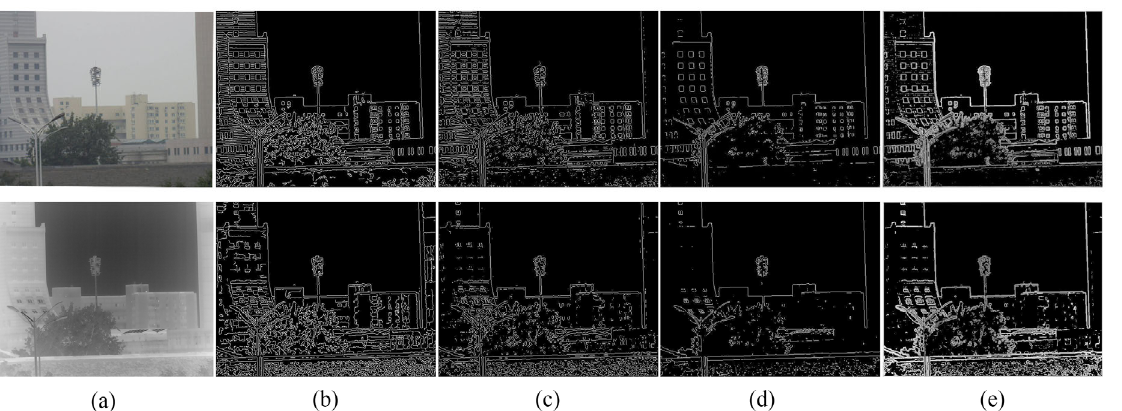
Figure 7. Evaluation function curves based on di ff erent edge algorithms: ( a ) overall; ( b ) canny; ( c ) LoG; ( d ) Sobel; and ( e ) proposed. It is necessary to highlight the contour edge features of infrared and visible images, while retaining more edge pixel information in our research. For further quantitative anal- ysis, we selected the edge entropy EH to analyze the e ff ect of edge algorithms on the de- gree of retention of image pixel information. We selected the range of function value change L and the number of local peaks β to analyze the e ff ect of di ff erent edge algorithms on the EGNMI evaluation function. EH is the entropy of the edge image, which re fl ects the degree of pixel information retained by the edge extraction algorithm. A larger value indicates that more pixel information is retained. It is de fi ned as ( )